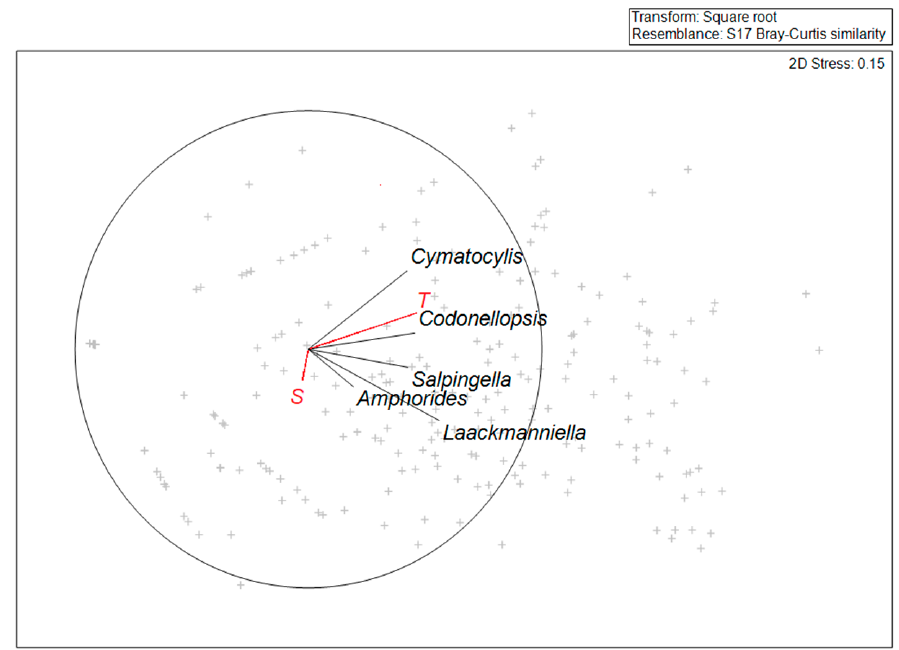
related to temperature, while there is no relationship to salinity.